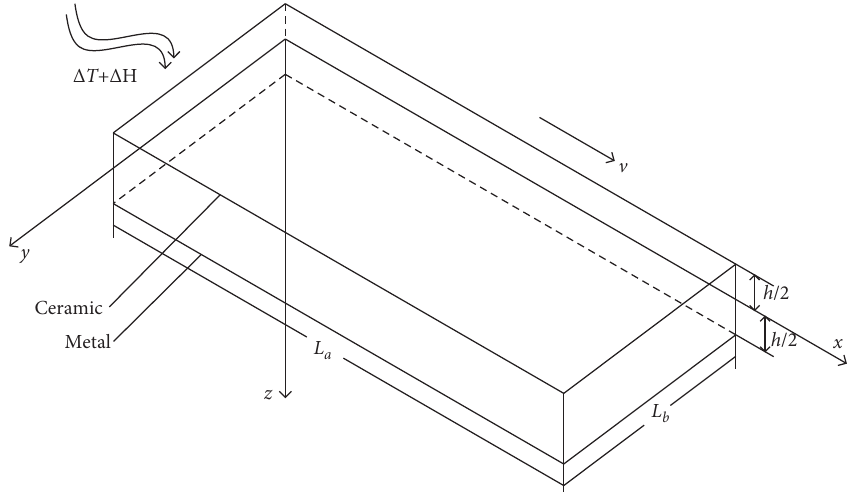
Figure 1: The schematic configuration of an axially moving functionally graded nanoplate in hygrothermal